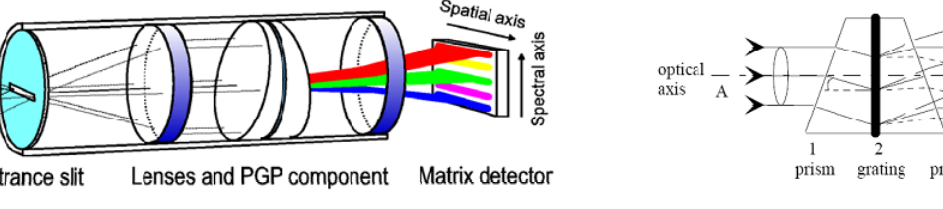
Figure 2. Schematic diagram of spectrograph ImSpector (left) and basic principle of the direct-vision element (right)